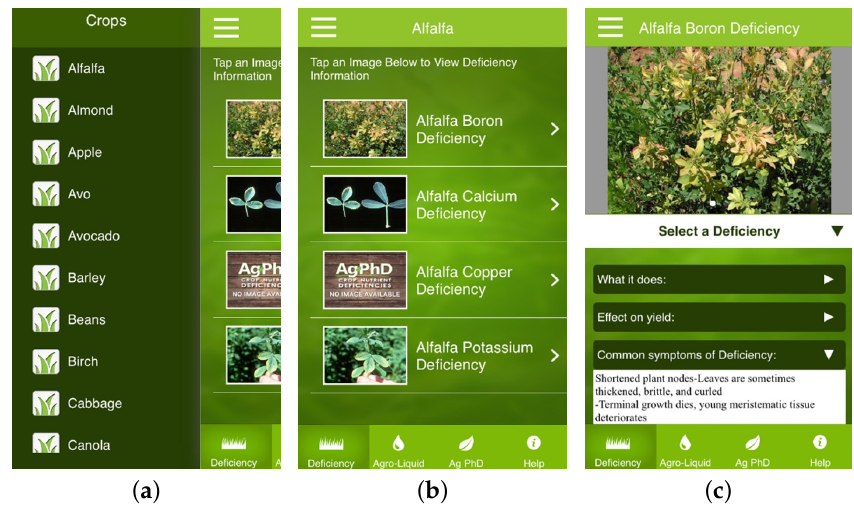
Figure 11. Crop Nutrient Deficiencies: ( a ) Crop type selection menu; ( b ) List of nutritional deficiencies; ( c ) Image and description of a specific nutritional deficiency.